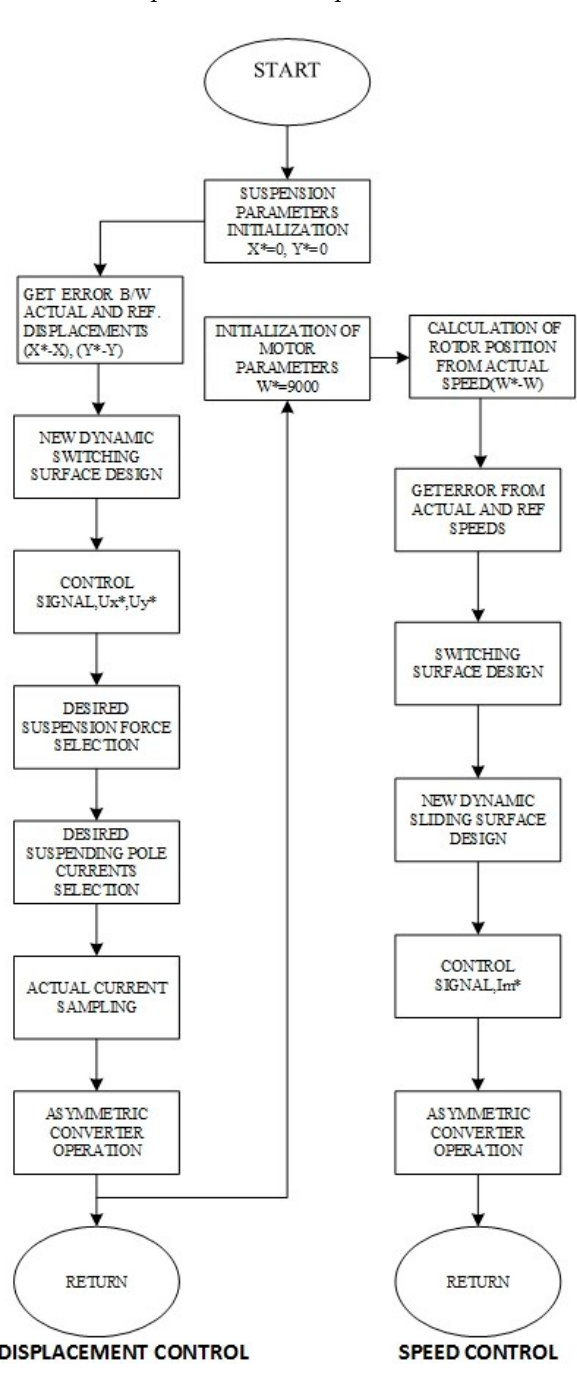
Figure 3. Stepwise flow chart for the implementation of the dynamic sliding mode control of the bearingless switched reluctance motor (BSRM).